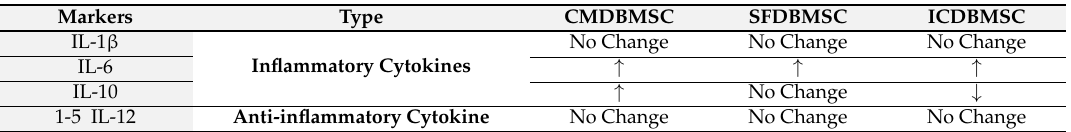
Table 3. DBMSC (CMDBMSC, SFDBMSC, and ICDBMSC) effects on macrophage secretion of inflammatory and anti-inflammatory cytokines as compared to untreated macrophages by ELISA. Increased ( ↑ ) and decreased ( ↓